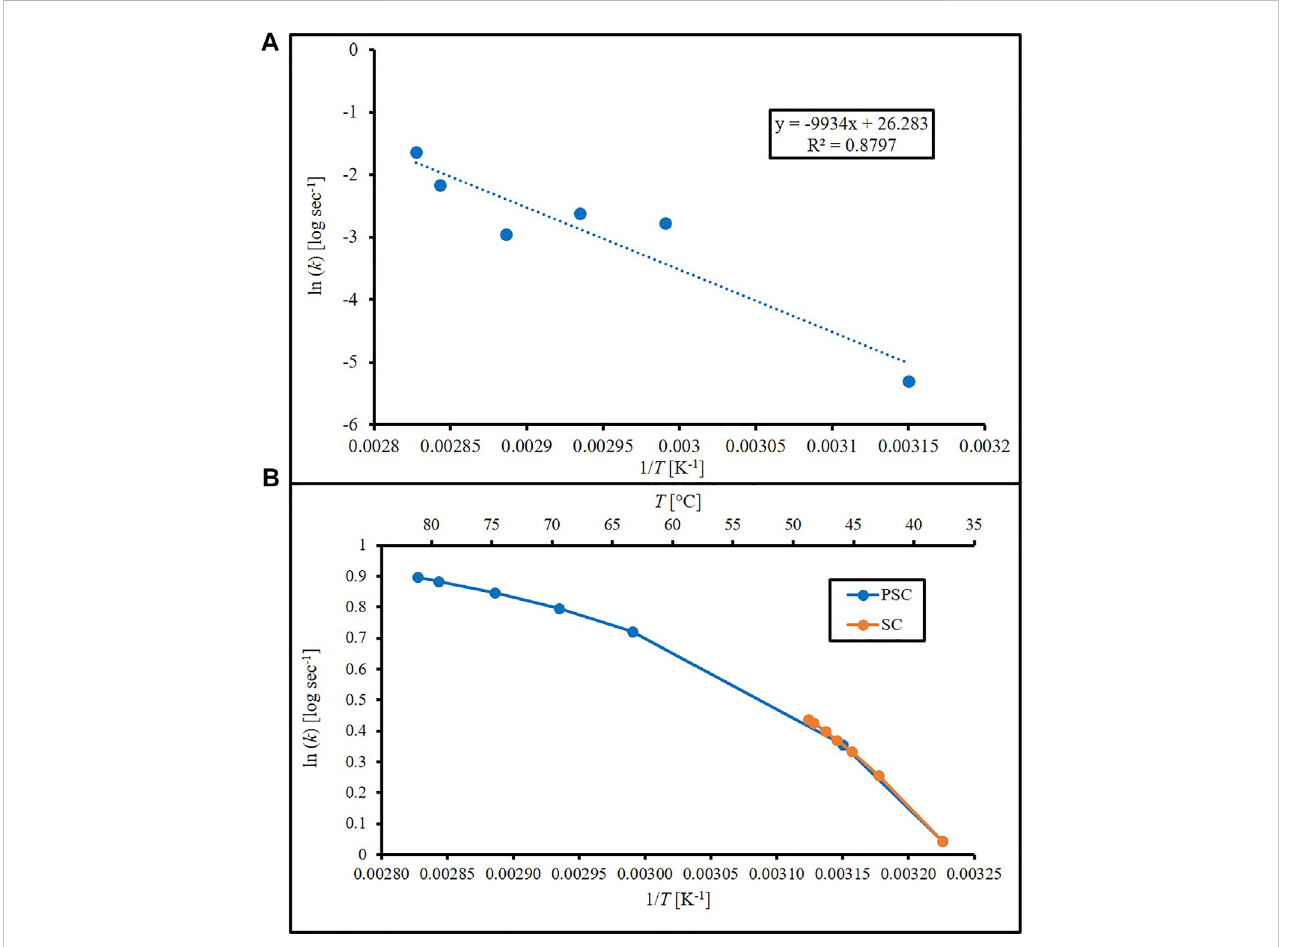
Arrhenius plots (natural log of cell death rate against 1/T) using (A) cell death rates calculated from Arrhenius equation using PEDOT-infused silicone (PSC)datawithlinear regressionand (B) celldeathratesfromArrhenius-Eyring-Polanyiequation andliteratureconstantsforsilicone (SC)andPEDOT-infused silicone